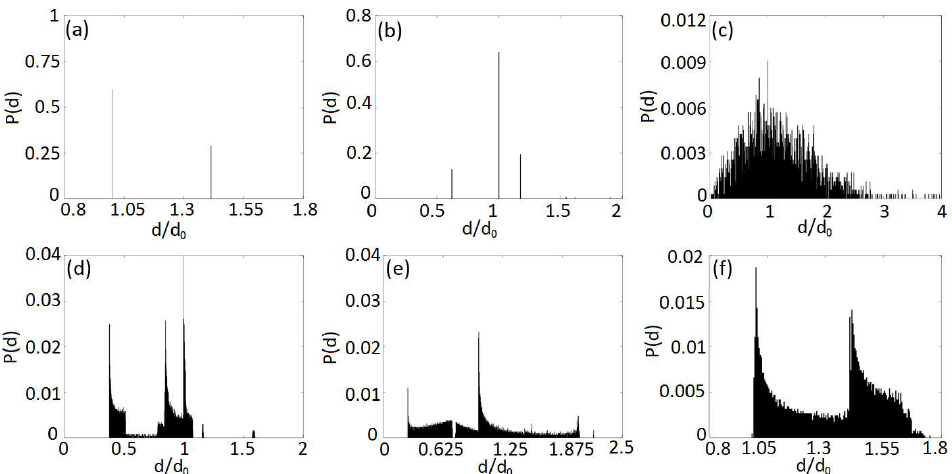
Figure 4. Probability distribution of Delaunay triangulation edge lengths. ( a ) N = 1024 square array; ( b ) N = 1108 Penrose array; ( c ) N = 1000 pseudo-random array; ( d ) N = 1000 µ -spiral